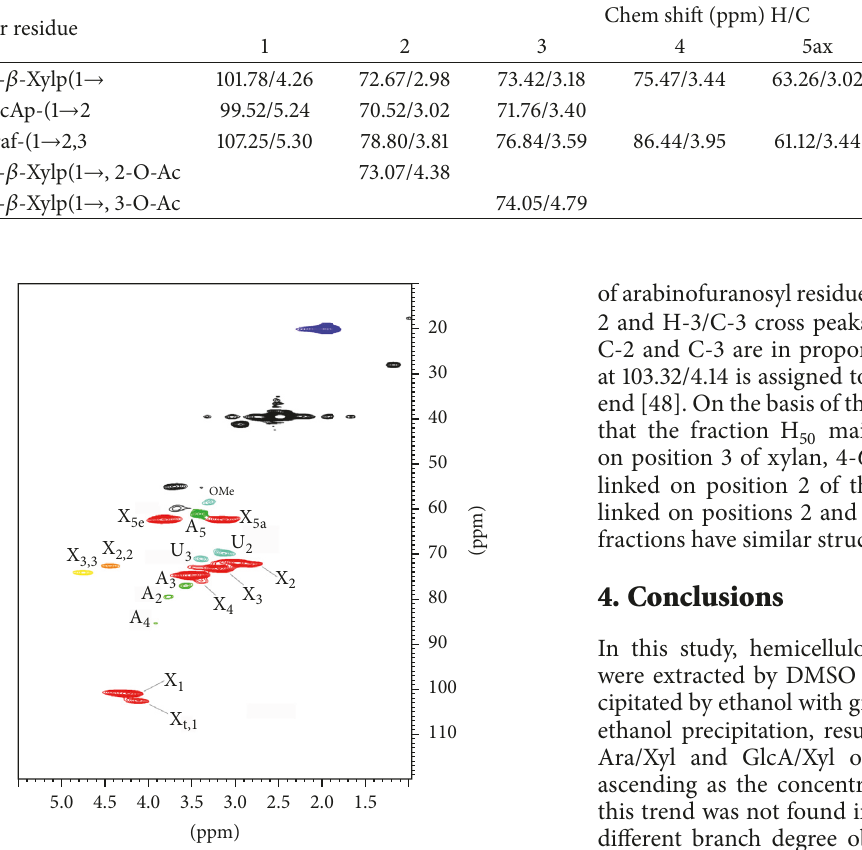
Figure 6: HSQC spectrum of hemicellulosic fraction H 50 . Desig- nations are as follows: X, Xyl p ; A, Ara f ; U, 4- O -Me- 𝛼 -Glc p A; X 2 , 2- O -acetylated Xyl p ; X 3 , 3- O -acetylated Xyl p ; Xt, nonacetylated xylose with terminal